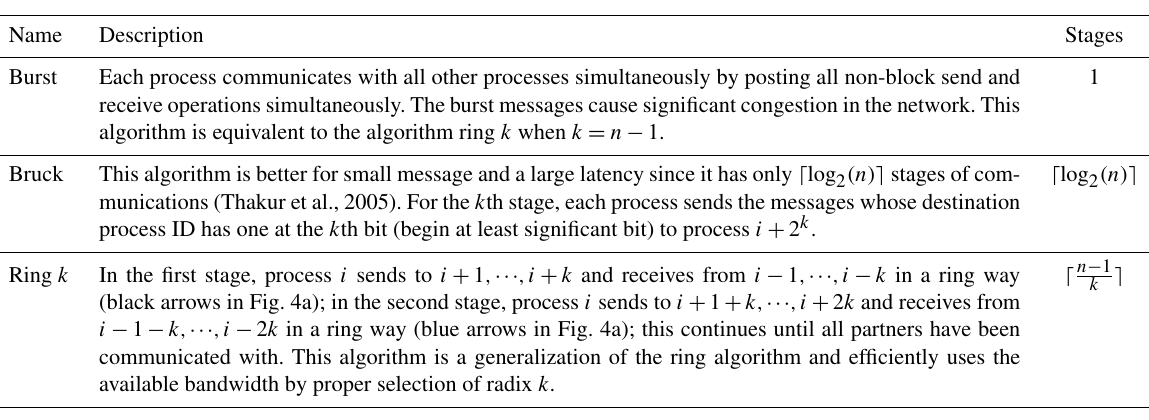
Table 2. Three algorithms for all-to-all personalized